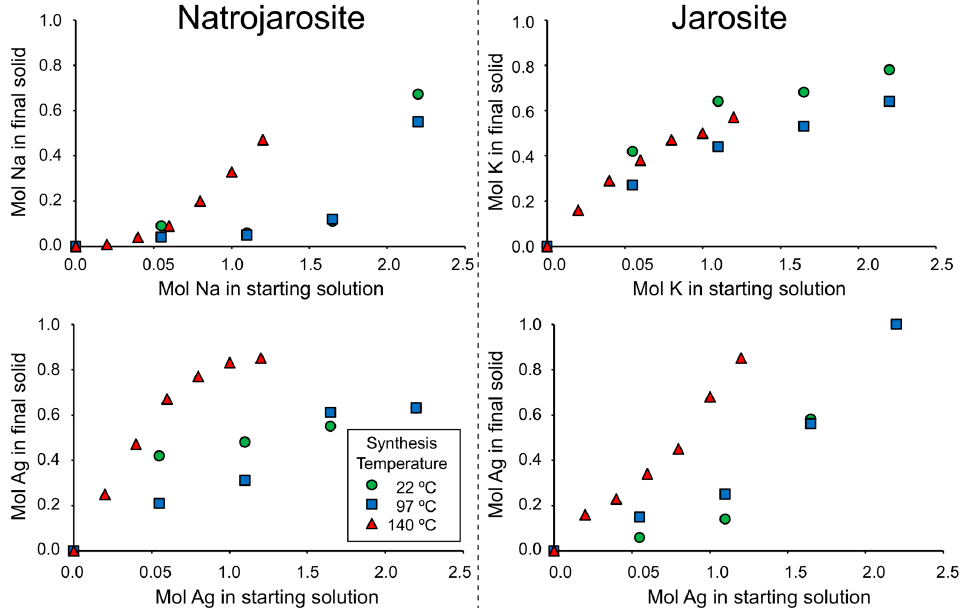
Figure 4. Comparison of moles of Na, K and Ag in the starting solutions with moles of Na, K and Ag in the final synthesised natrojarosite and jarosite solids. in the final synthesised natrojarosite and jarosite solids.